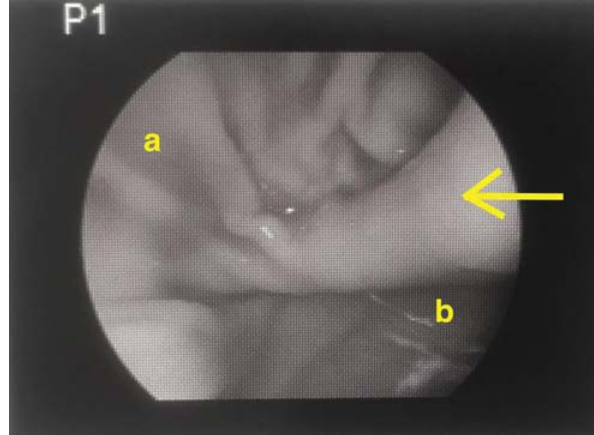
Fig. 3 Laparoscopic view of the mucosal diaphragm (arrow). a, proximal part (stomach); b, distal part